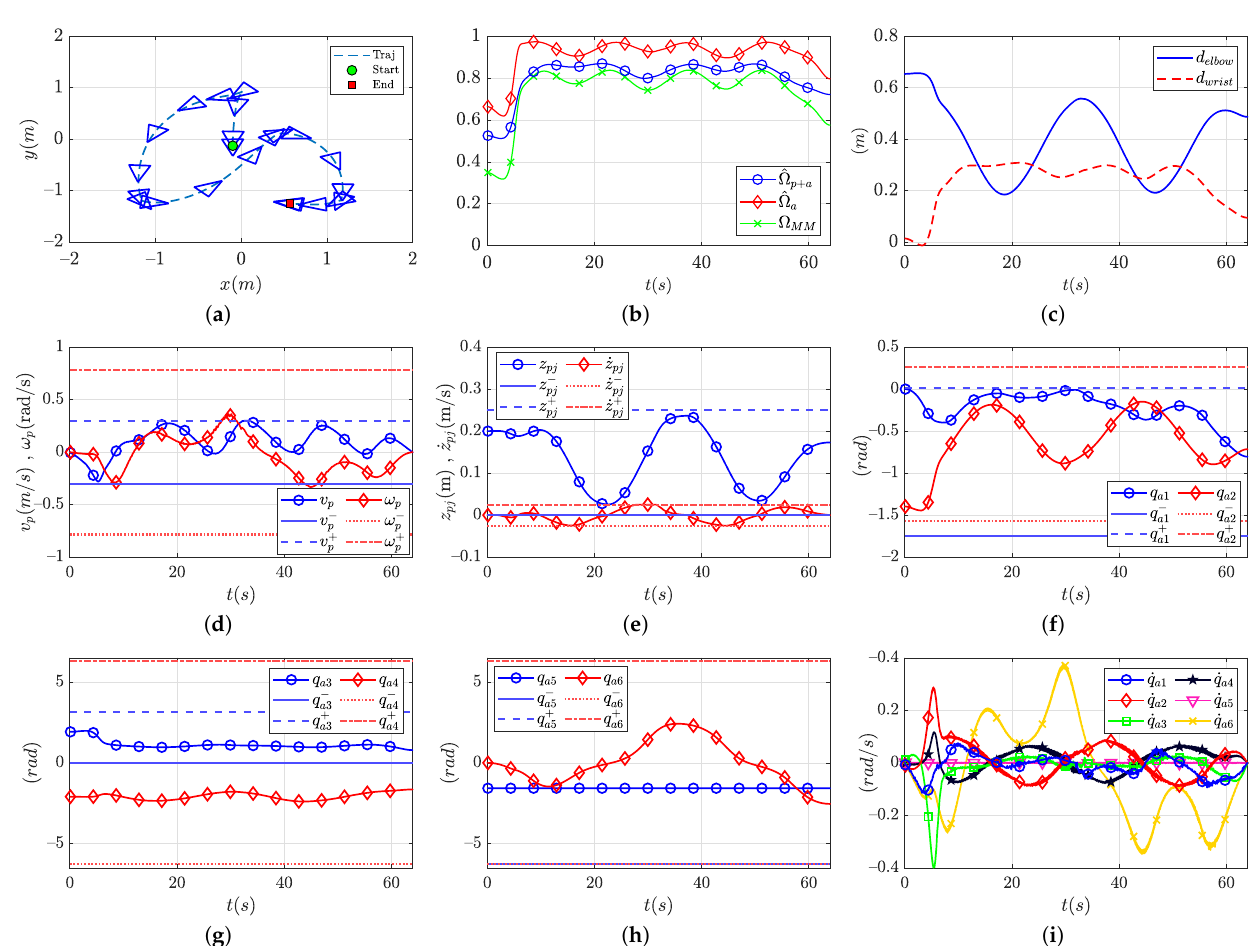
Figure 8. Experiment results for the Lissajous trajectory tracking: ( a ) mobile platform’s trajectory; ( b ) normalized manipu- lability measures; ( c ) self-collision distances; ( d ) mobile platform’s velocity commands; ( e ) prismatic joint’s position and velocity; ( f – h ) arm’s joint positions; and ( i ) arm’s joint velocities. Notice that all the joint limits and velocity limits are respected (panels ( d – i )). Furthermore, the manipulabilities of both the arm and the whole system are improved (panel ( b )). See Section 5.4 for a detailed discussion of this